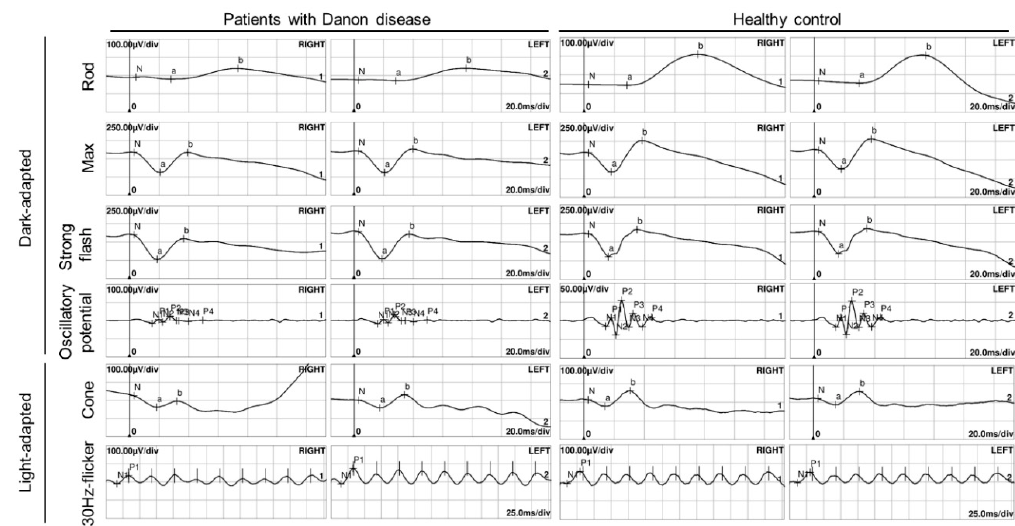
Figure 5. Electroretinogram of the patient after twelve years of follow-up ( left ) and healthy control ( right ).